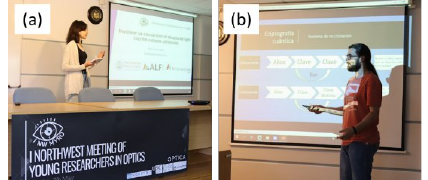
Fig. 2. Young researchers a) moderating the session and b) presenting their research lines.